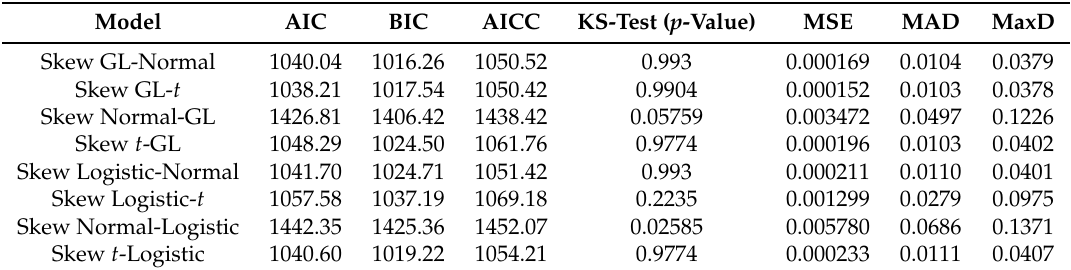
Table 2. Performance and accuracy of the